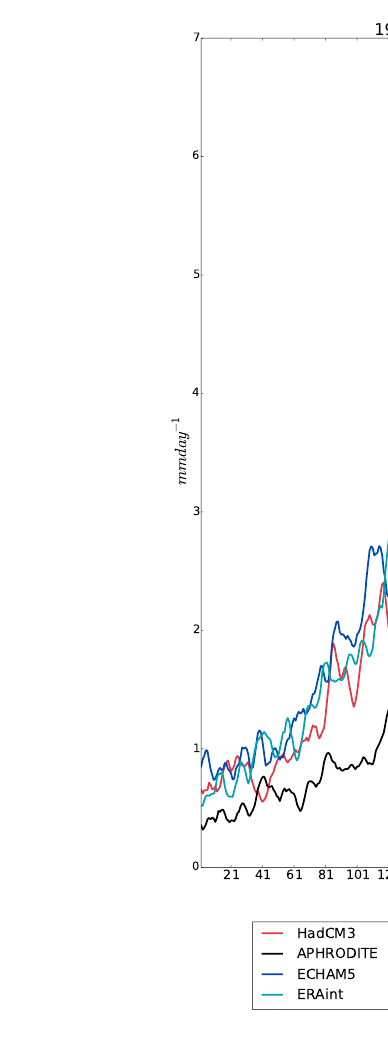
Figure 1. The 1.5-year precipitation climatology for the 1990–2007 period averaged for South Asia for each simulation (ERA-Interim (la- belled “ERAint” in the figures throughout the paper) cyan line, ECHAM5 blue line, HadCM3 red line) and APHRODITE observations (black line) using a 5-day smoothed rolling mean. Also shown are the growing seasons averaged for 1990–2007 for South Asia for wheat (orange) and rice (green) from two datasets: Sacks et al. (2010) (diagonal hatching-labelled sacks) and Bodh et al. (2015) (perpendicular hatching- labelled Minag) and the monsoon onset (blue vertical lines) and retreat (pink vertical lines) from each of the simulations (APHRODITE dotted, ERA-Interim dashed, HadCM3 solid, ECHAM5 dash